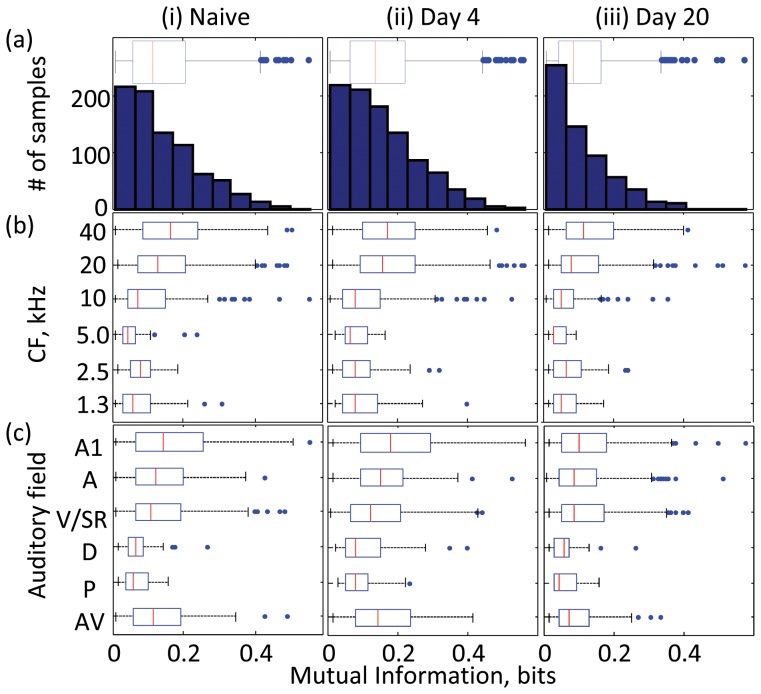
Distribution of mutual information.(a) Histogram of entire data: (i) naïve (n = 838); (ii) day 4 (n = 965); and (iii) day 20 (n = 618). (b) CF-dependent distribution. On each box, the central mark is the median, and the edges of the box are the 25th and 75th percentiles. The whiskers extend to the most extreme data points (maximum and minimum values) not considered outliers, which are larger than the 75th percentiles or smaller than the 25th percentiles by 1.5 times the inter-quartile range. (c) Auditory-field-dependent distribution.